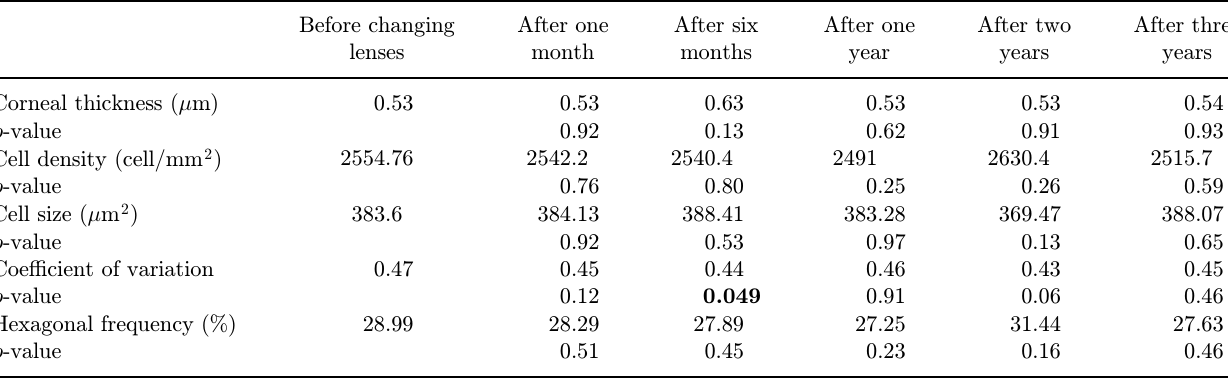
Table 1. The results from Group 1: parameters of the corneal physiology (corneal thickness and endothelial morphology). Before changing After one After six After lenses month